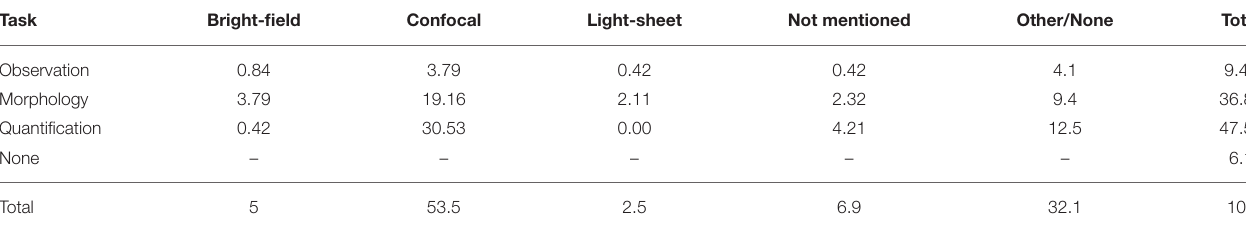
TABLE 4 | Percentage of articles per microscopy and per task performed for the analysis of cerebral